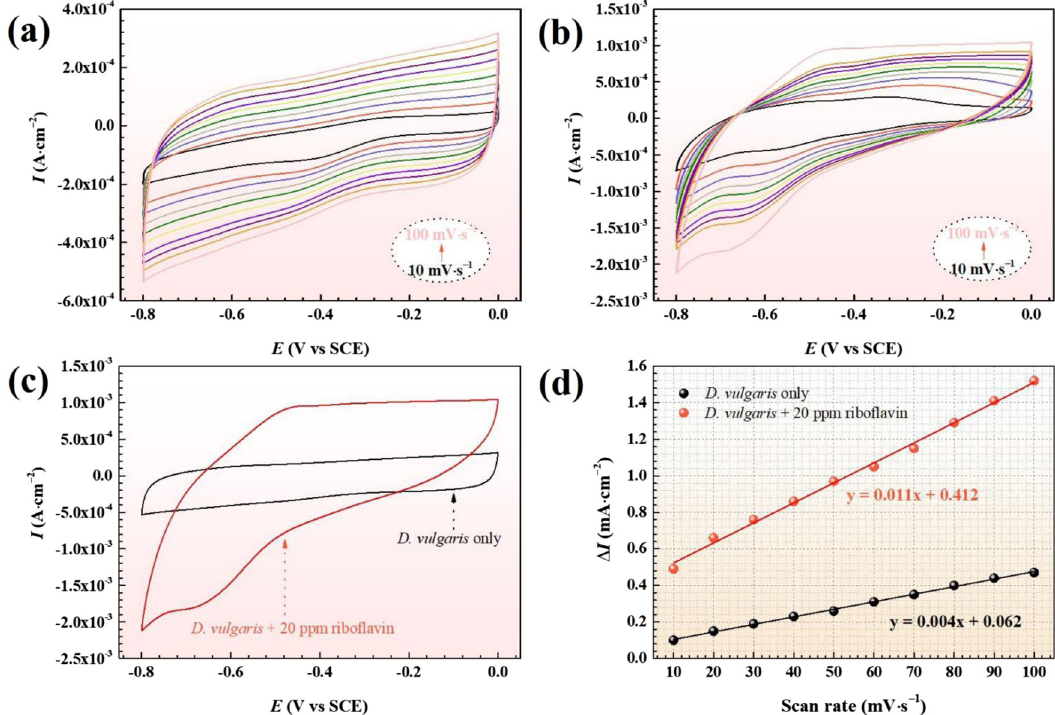
Fig. 8 CV. CV of bio fi lm in the PBS after the 7-d incubation in the D. vulgaris media without ( a ) and with ( b ) ribo fl avin by various scan rates, c comparison of CV curve without (black) or with (red) the ribo fl avin by 100 mV s − 1 scan rate, d current density differences plotted against scan